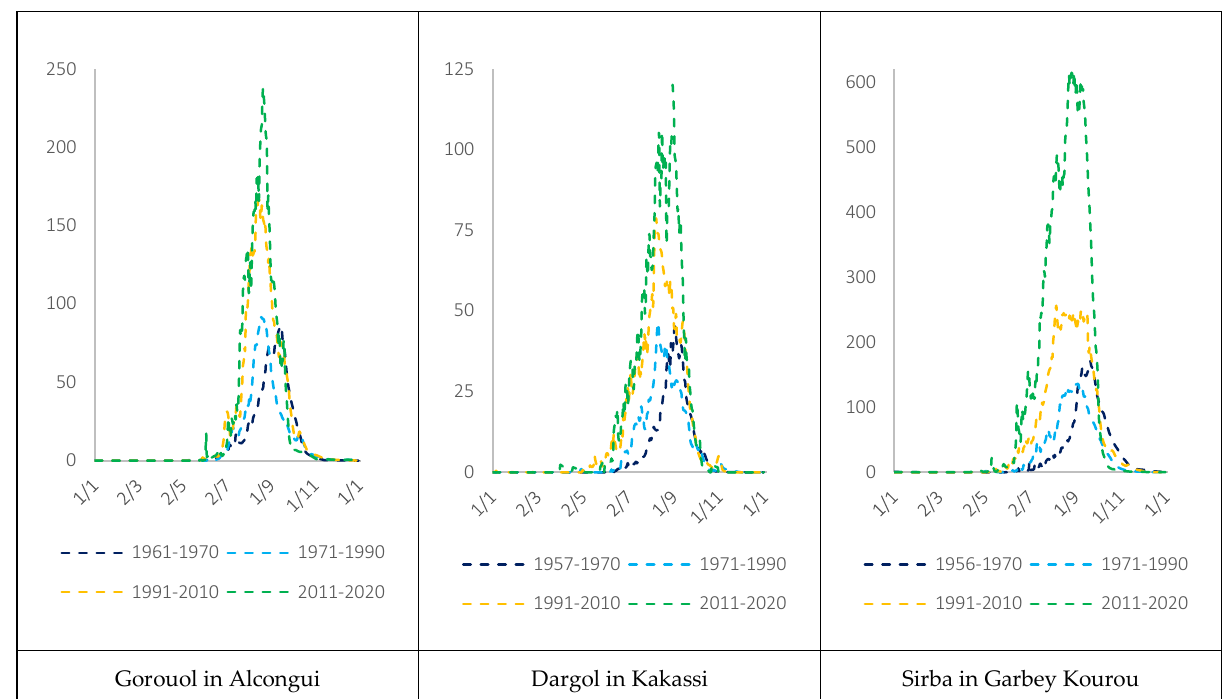
Figure 14. Intra annual mean hydrographs (m 3 /s) of the main Sahelian basins (Gorouol, Dargol and Sirba rivers) in the four hydrological periods (I:19.. – 1970, II:1971 – 1990, III:1991 – 2010 and IV: 2011 – 2020).